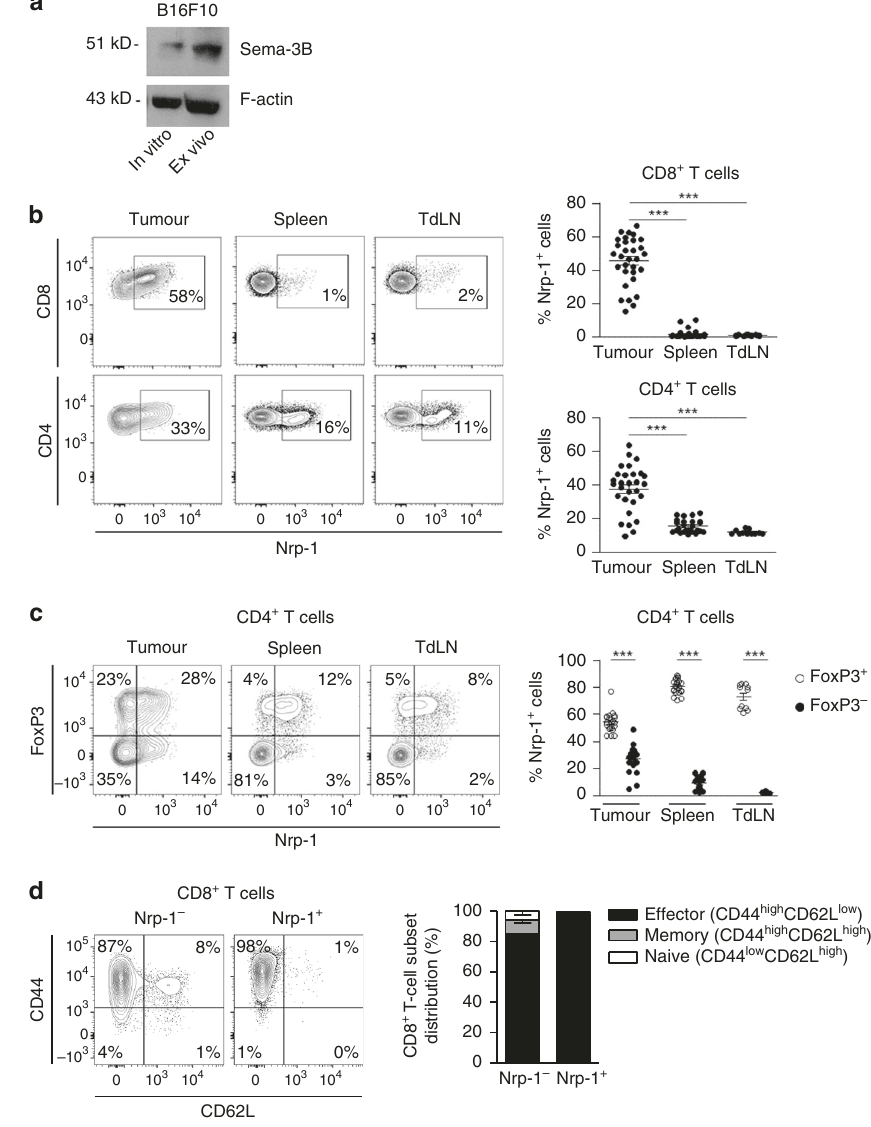
Fig. 3 Expression of Sema-3B and Nrp-1 in B16F10 mouse melanoma model. a Expression of Sema-3B in B16F10 tumour cells. Total protein extracts from B16F10 cells cultured in vitro or isolated ex vivo from tumour grafts were analysed by western blot using anti-Sema-3B mAb. b Surface expression of Nrp-1 on CD4 + and CD8 + T cells in fi ltrating B16F10 melanoma engrafted in C57BL/6 mice. TIL from individual tumours were isolated at day 15 after tumour cell inoculation. T lymphocytes from spleens and TdLN of tumour-bearing mice were analysed in parallel. Percentages of positive cells are included. Right: percentages of Nrp-1 + cells among CD8 + and CD4 + T cells in TIL ( n = 29 and 31), splenocytes ( n = 29 and 31) and TdLN ( n = 11 and 16). c Expression of Nrp-1 and FoxP3 in CD4 + T cells. T lymphocytes from tumours ( n = 20), spleens ( n = 22) and TdLN ( n = 11) of B16F10 melanoma-bearing mice were analysed at day 15 by fl ow cytometry. Right: percentages of Nrp-1 among FoxP3 + and FoxP3 − CD4 + T lymphocytes from B16F10. d Expression of CD44 and CD62L on Nrp-1 + and Nrp-1 − CD8 + T cells from B16F10 TIL. Right: Distribution of naive, effector and memory T cells populations among Nrp-1 − and Nrp-1 + CD8 + TIL ( n = 10). Results are representative of 3 – 5 independent experiments. Means ± SEM one-way ANOVA test with Bonferroni correction b or two-way ANOVA test with Bonferroni correction c . * P < 0.05; ** P < 0.01; *** P < 0.001. Source data are provided as a Source Data fi le a ,